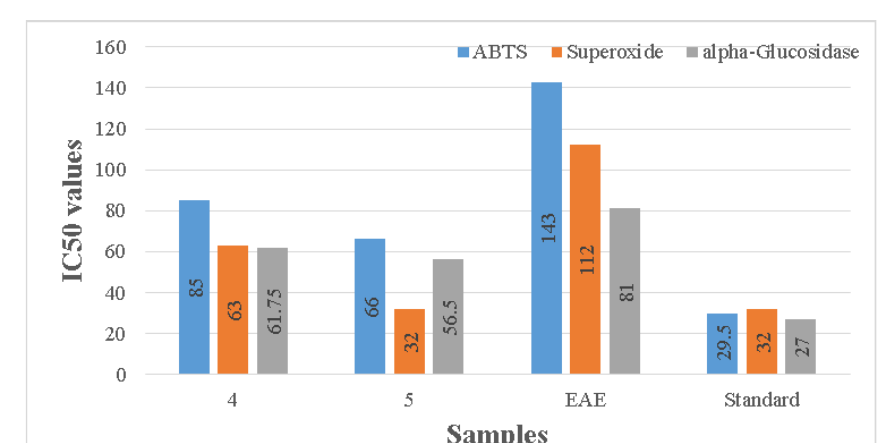
FIGURE 2 – IC values of metabolites and EAE against ABTS, superoxide free radicals and α-glucosidase 50